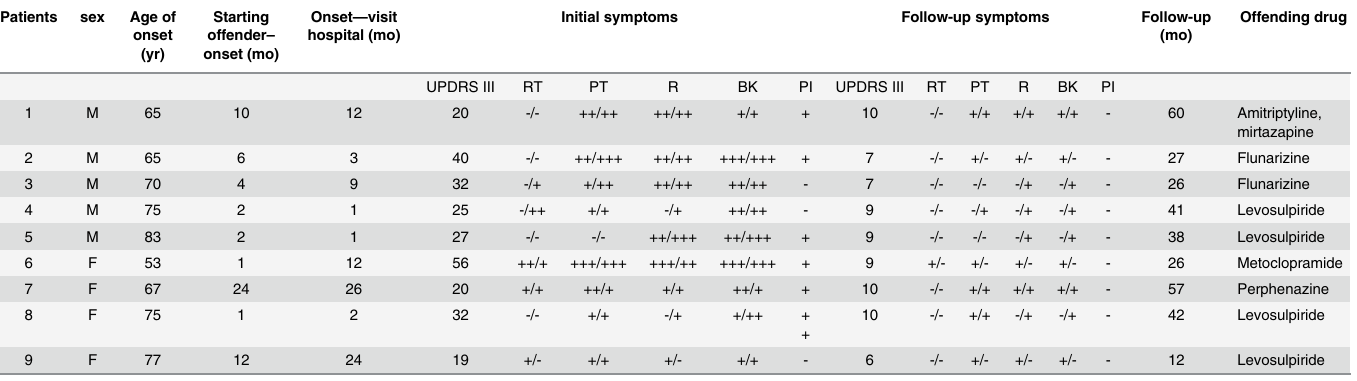
Table 3. Clinical information for partially recovered patients with drug-induced parkinsonism. Patients sex Age of onset